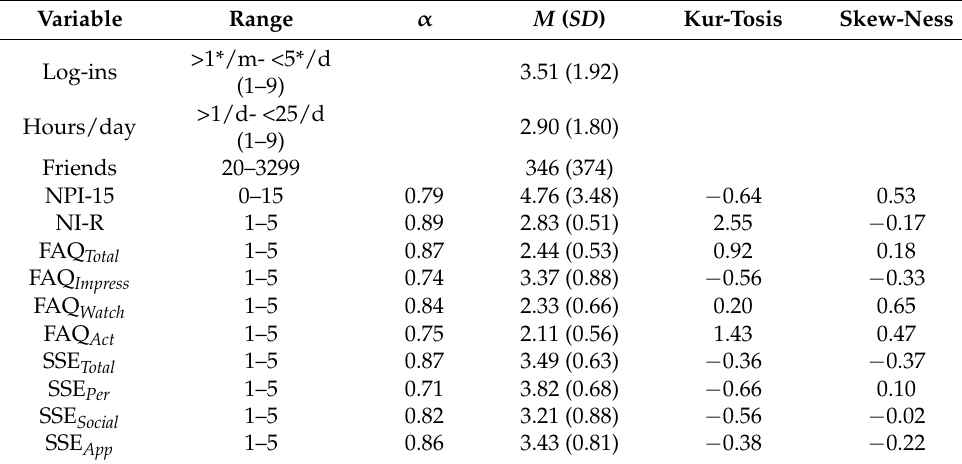
Table 1. Descriptive statistics of the measures employed in the